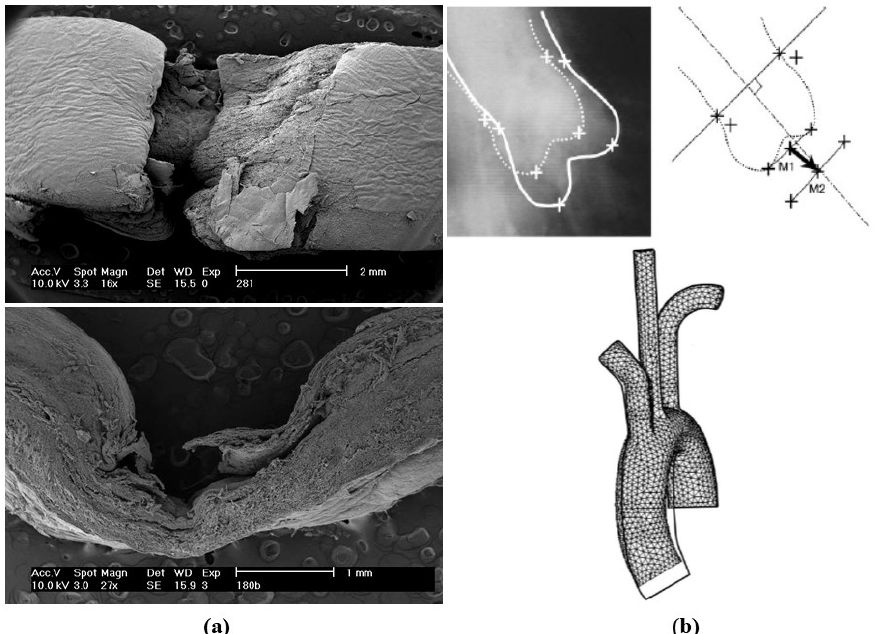
Figure 19. ( a ) Scanning electron microscopy views of an intimal tear in aortic dissection. ( b ) Stretch of the aorta during hypertension attack, accounting for intimal tear and aortic dissection. Adapted from [29], with permission.